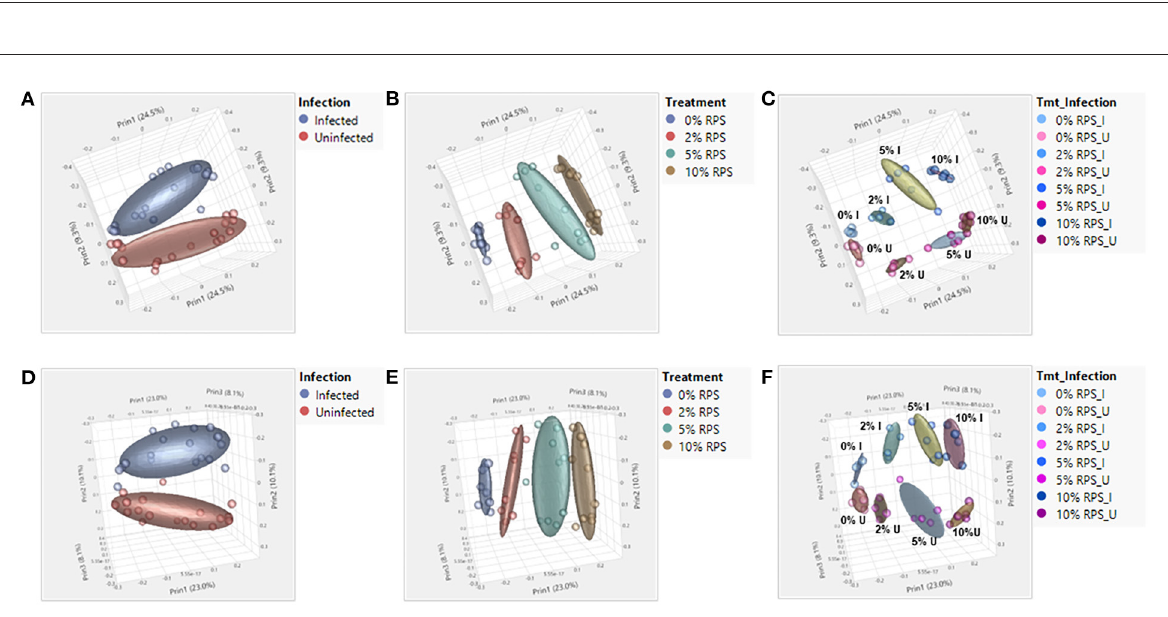
FIGURE4 Both feeding RPS diets and Cr infection leads to distinct grouping by PCA analysis in fecal and cecal samples. PCA analyses were performed using JMP Genomics and analyzed based on diet, infection, and the combination of the two. n = 4–5 mice/group, eight groups, four uninfected and four infected. (A–C) are for cecum samples and D-F for fecal samples. (A, D) PCA illustrating the effect of infection on the microbiome regardless of dietary intake; (B, E) PCA illustrating the effect of dietary RPS levels only on the microbiome; (C, F) PCA illustrating the effect of diet and infection on the